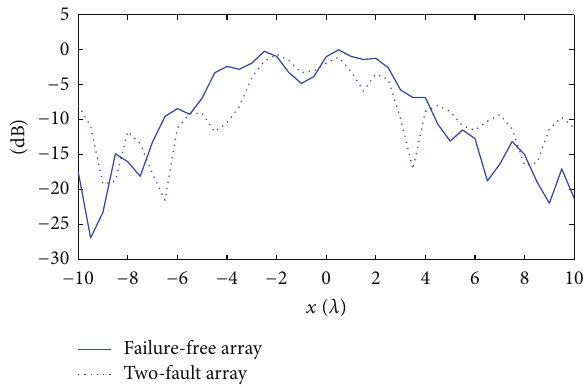
Figure 11: Measured near-field amplitude [dB] in the absence and presence of failures (slots 3 and 11 closed).